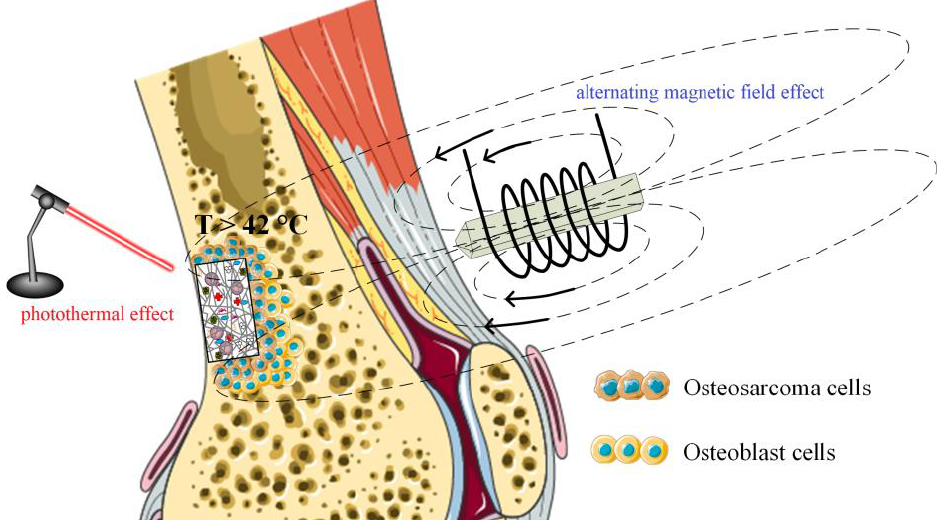
Figure 9. Magnetic hyperthermia and photothermal therapy treatment for oncological disease in BTE. The figure was generated using images assembled from Server Medical Art, which are licensed under a Creative Commons Attribution 3.0 unported license (https://smart.servier.com, accessed on 9 January 2023).